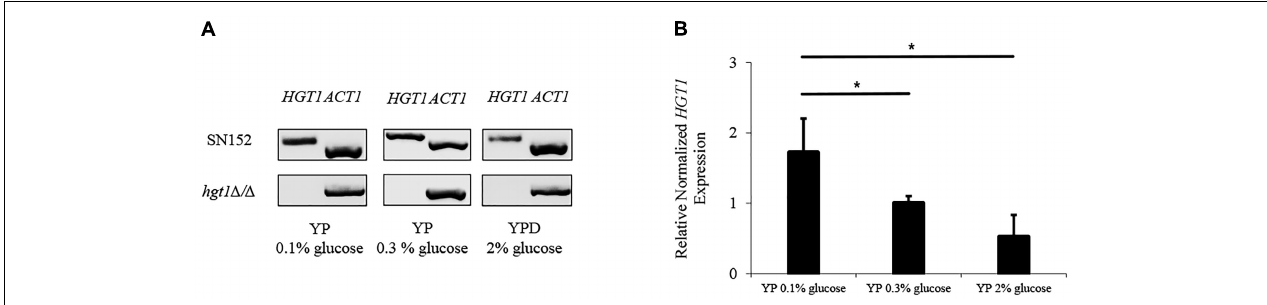
FIGURE 2 | Glucose dependent HGT1 expression. (A) Electrophoresis of qPCR products (cropped figure from same experiment, Supplementary Figure S1 ). (B) Expression of HGT1 normalized to ACT1 . The electrophoresis run shown is a representative of three separate experiments. HGT1 expression was normalized to ACT1 , a constitutively expressed housekeeping gene that did not show significant differences in expression at different glucose concentrations. The graph shows the average of three separate experiments. Bars represent the mean + SD. Significance ( ∗ p < 0.05) was determined by one-way ANOVA, using SN152 for comparison.